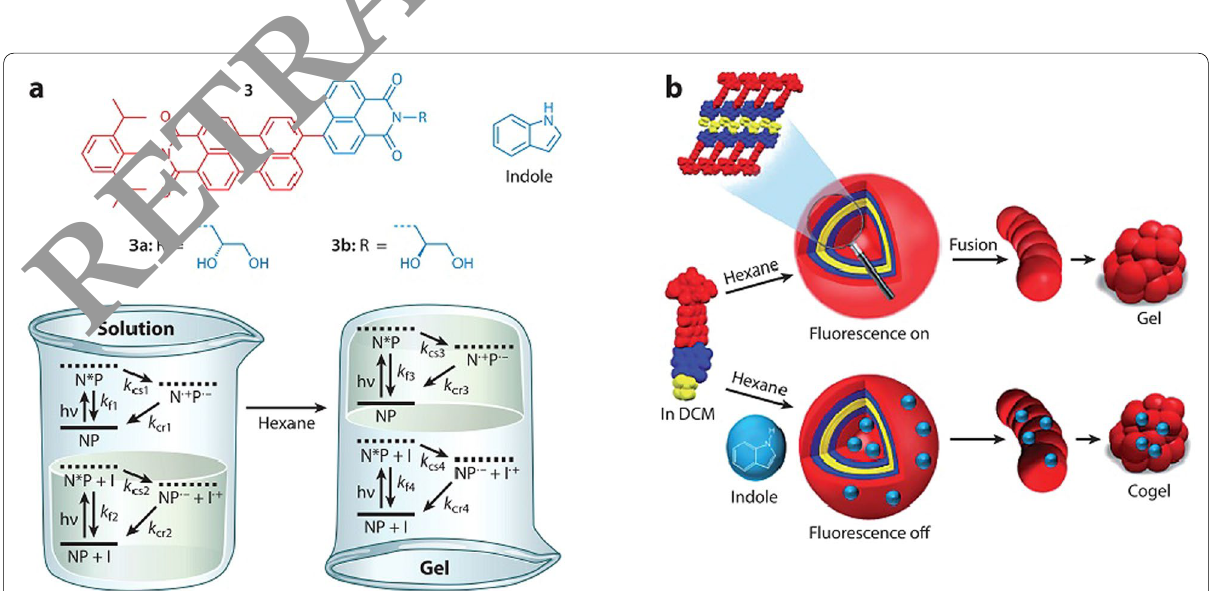
Fig. 5 a , b . The molecular structure of a conductive gel synthesized from naphthalimide as the electron donor and perylene monoimide as the electron acceptor in a hexane/dichloromethane solution medium to enhance the electron, transfer kinetics in the three-dimensional structure of the gel, Indole is also used as an intermediate donor unit has been